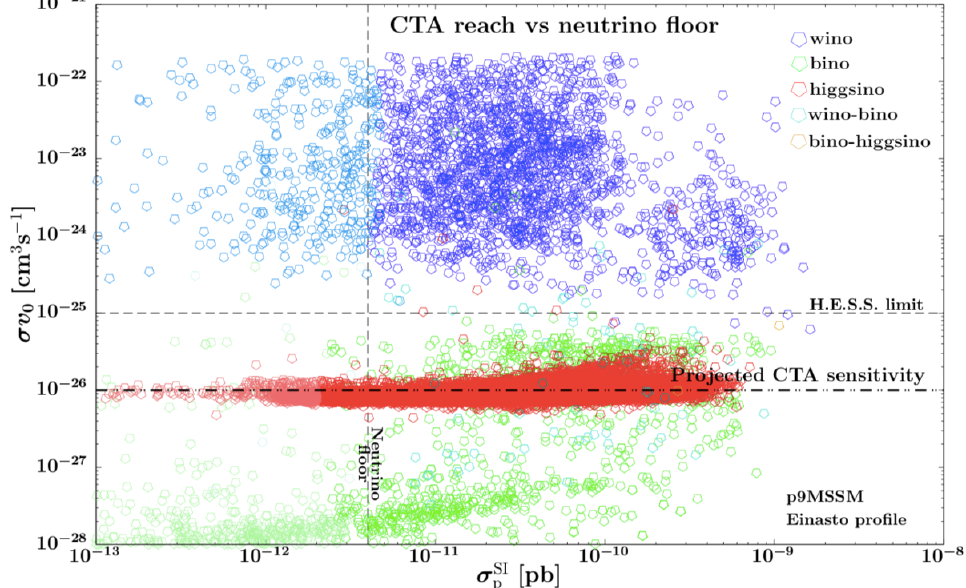
Figure 4. The points of the p9MSSM in the ( (cid:27) SI , (cid:27)v 0 ) plane. Color coding is the same as p in (cid:12)gure 2. The upper limit on (cid:27) SI is determined by the current sensitivity of XENON1T, included p in the global likelihood function. The shaded region covers the points lying below the irreducible neutrino (cid:13)oor. To guide the eye we add a vertical dashed line with reference value of the neutrino background limit taken at m (cid:31) = 2 TeV. The dashed horizontal line denotes the H.E.S.S. 95% C.L. upper limit, taken at m (cid:31) 2 : 5 TeV, while the dashed double-dotted horizontal line denotes the (cid:25) approximate CTA reach, taken at m (cid:31) 1 (cid:25)